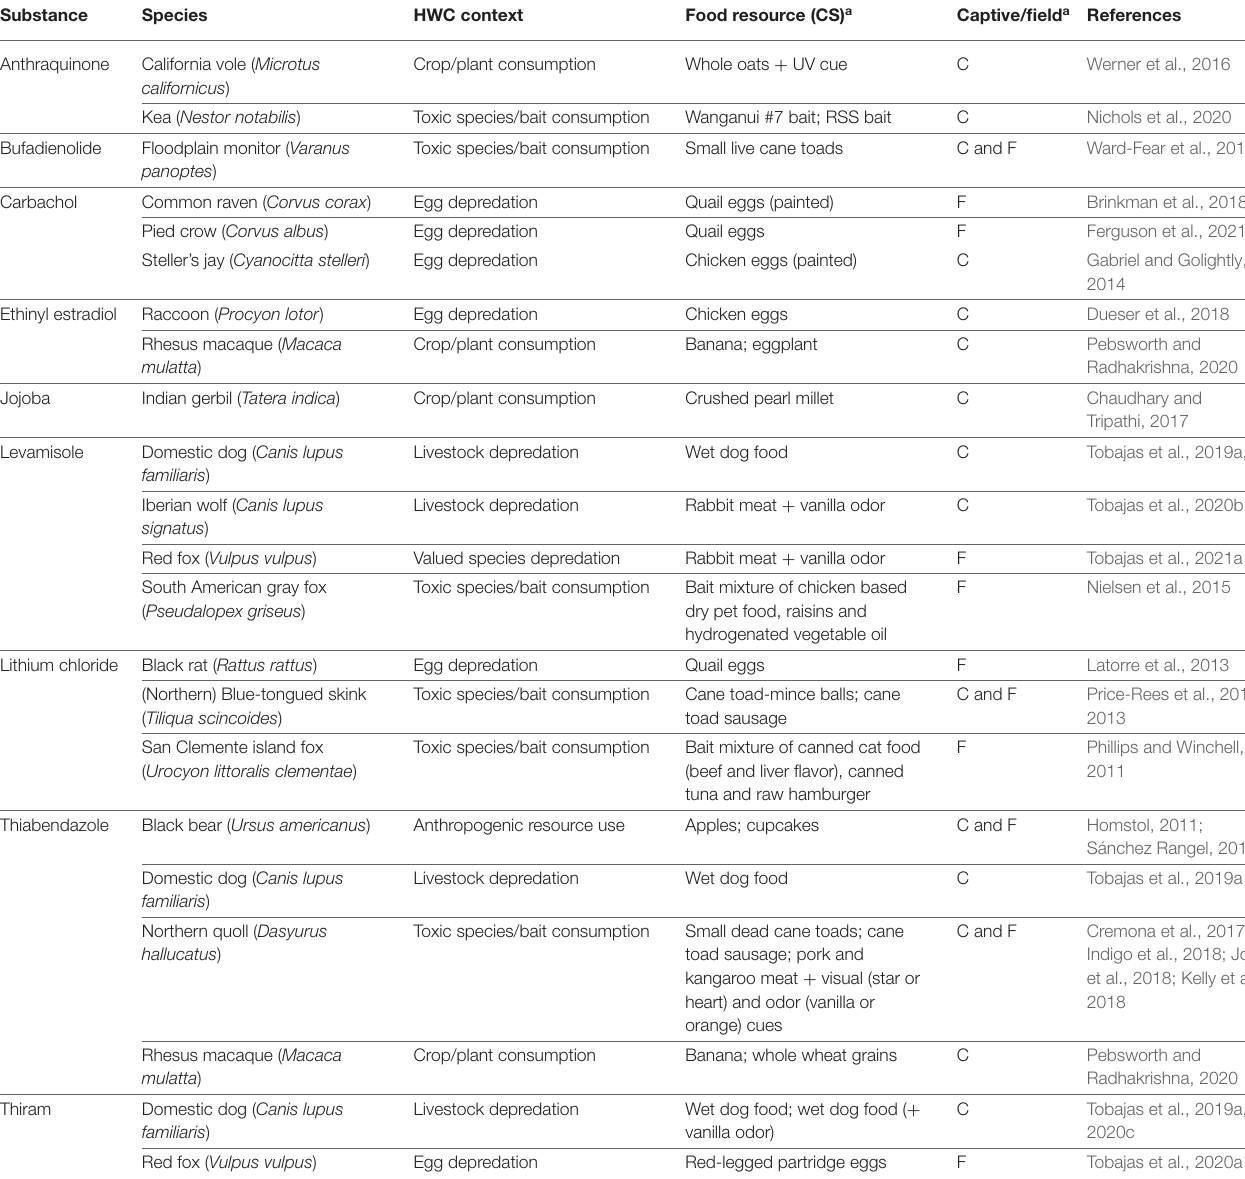
TABLE 2 | Examples of emetics used in the last 10 years that were reported to, in some degree, successfully (as defined by the authors of the respective studies) induce CTA to a conditioned stimulus (CS) in a current or prospective future wildlife conservation or management